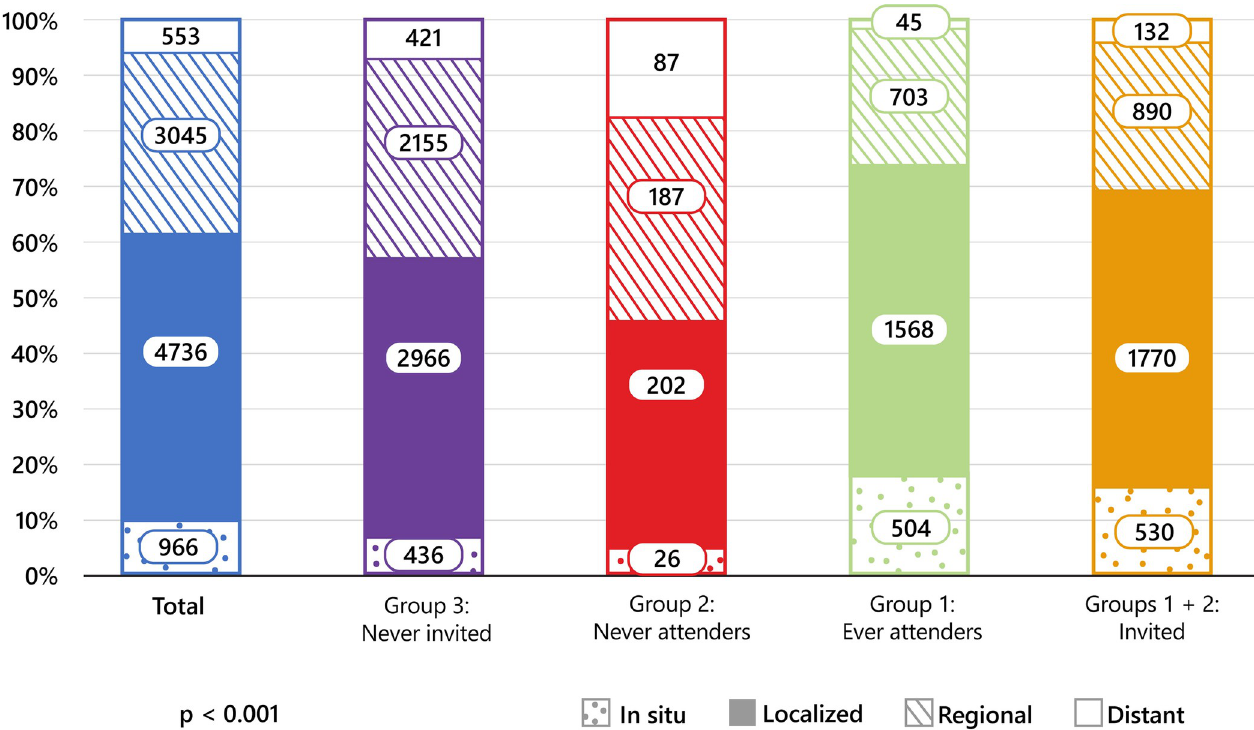
Fig 2. Number and proportion of women with breast cancer aged 50–74 years by screening programme status and stage at diagnosis, Slovenia, 2008– 2018. 1 At least one mammography screening in organized screening programme prior to diagnosis. 2 At least one invitation to screening programme, but no screening performed. 3 No history of invitation or mammography within the screening